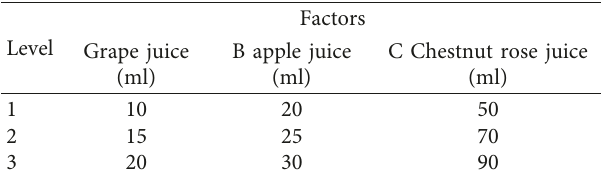
Table 4: Orthogonal experiments for the fermentation of complex